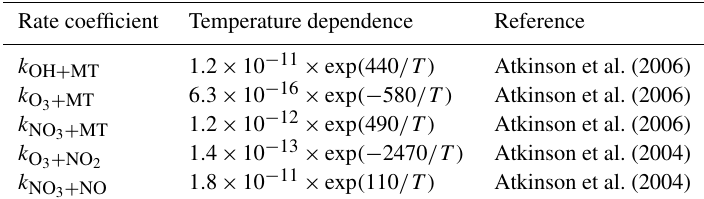
Table A1. The temperature ( T ) -dependent relations of different reaction rate coefficients.